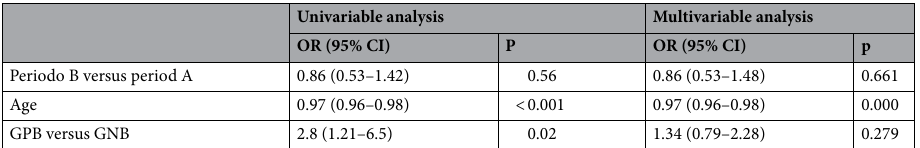
Table 4. Factors associated with the risk of ICU stay in univariate and multivariate analysis. GPB Gram- positive bacteria, GNB Gram-negative